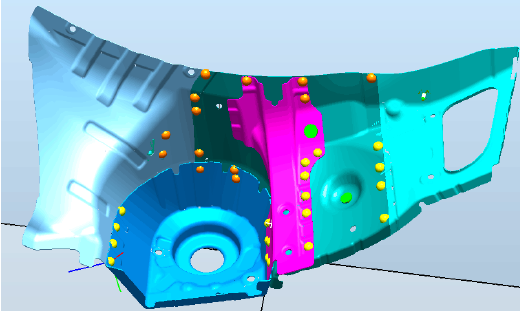
Figure 1. Body in white weld